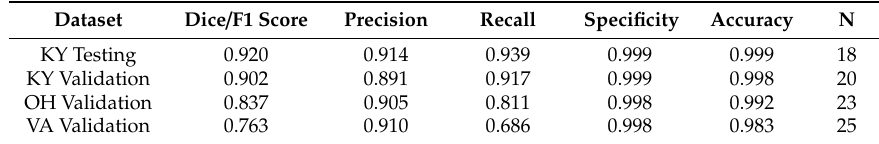
Table 5. Validation results using topographic maps. Values represent the mean values for all topographic maps in the set. N = number of image chips in the dataset.